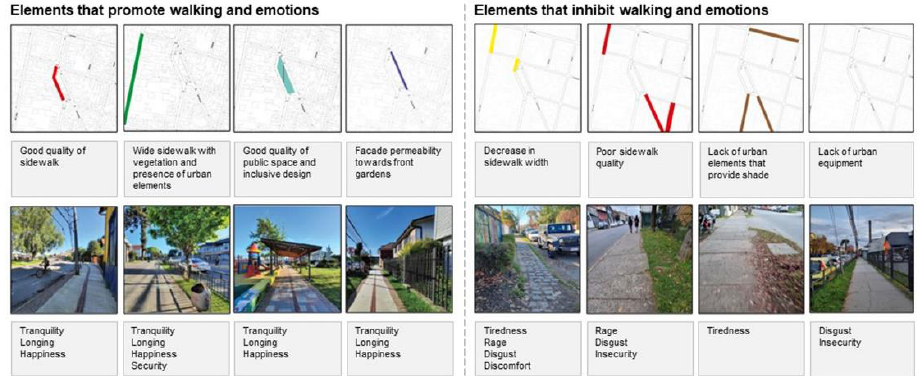
Figure 8. Elements that promote or inhibit walking, based on walkers’ perceptions in Barrios Bajos, Valdivia. Pictures were taken during interviews with participants, according to the elements that interviewers highlighted while walking. Source: Authors.